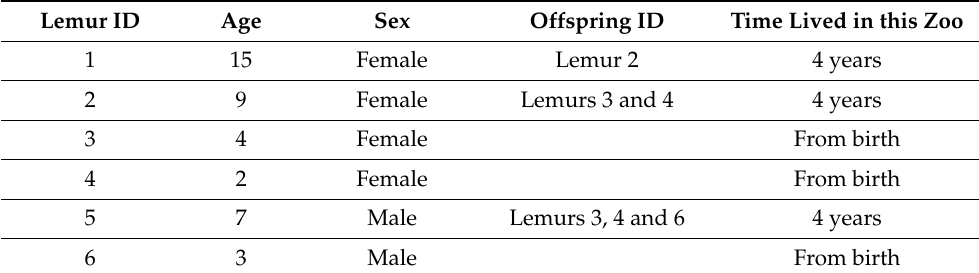
Table 1. Details of the ring-tailed lemurs involved in this study.